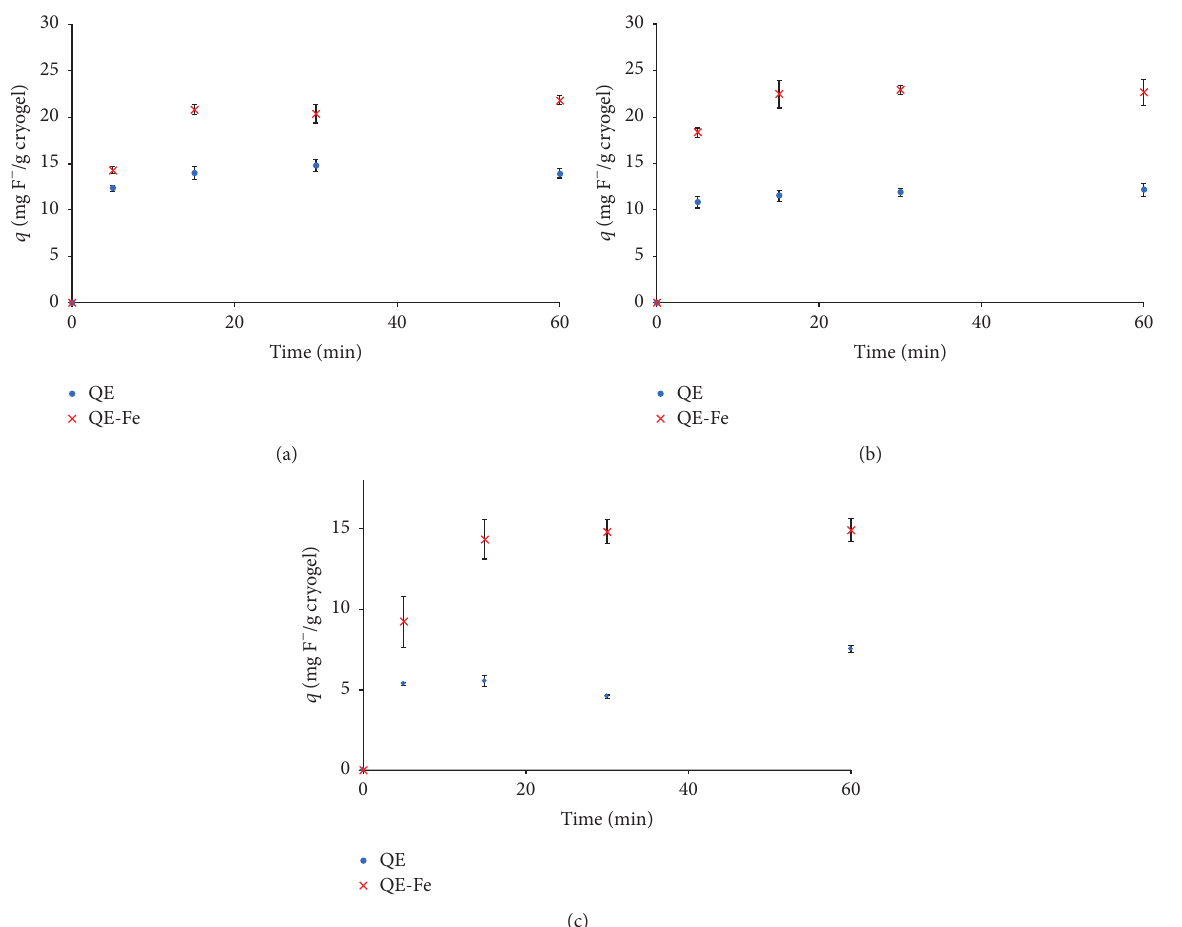
Figure 10: Sorption kinetics, 8 mL of 10 mgL −1 , 200 rpm, 0.002 g of cryogel mass, pH 6, closed atmosphere: (a) 303 K, (b) 313 K, and (c) 323 K.